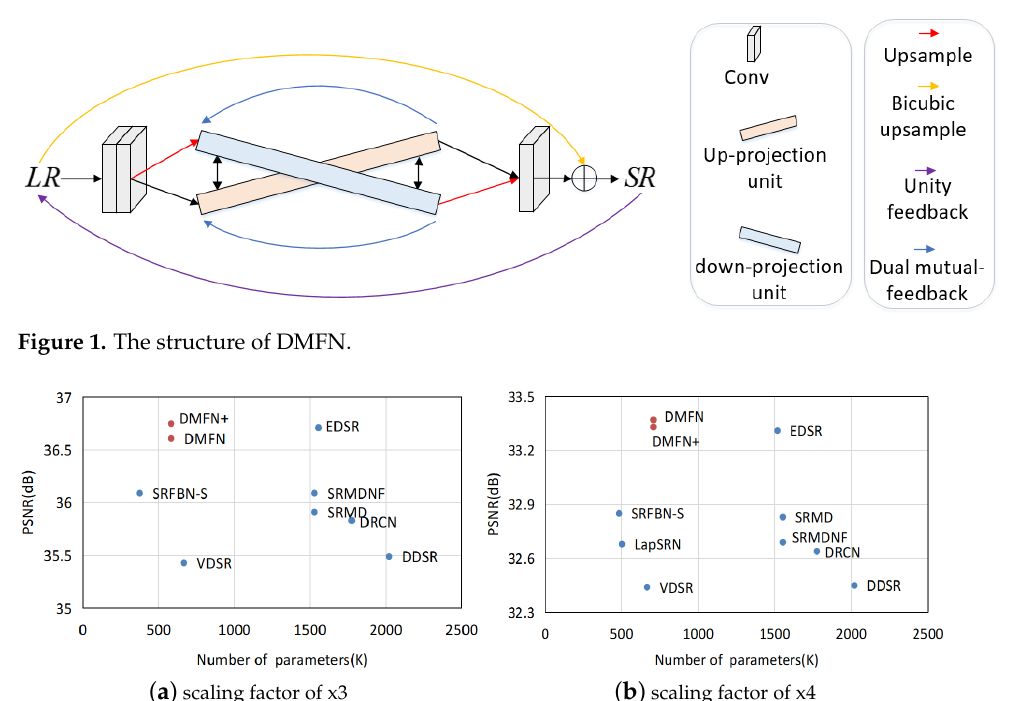
Figure 2. PSNR vs. parameters on MRI13 in